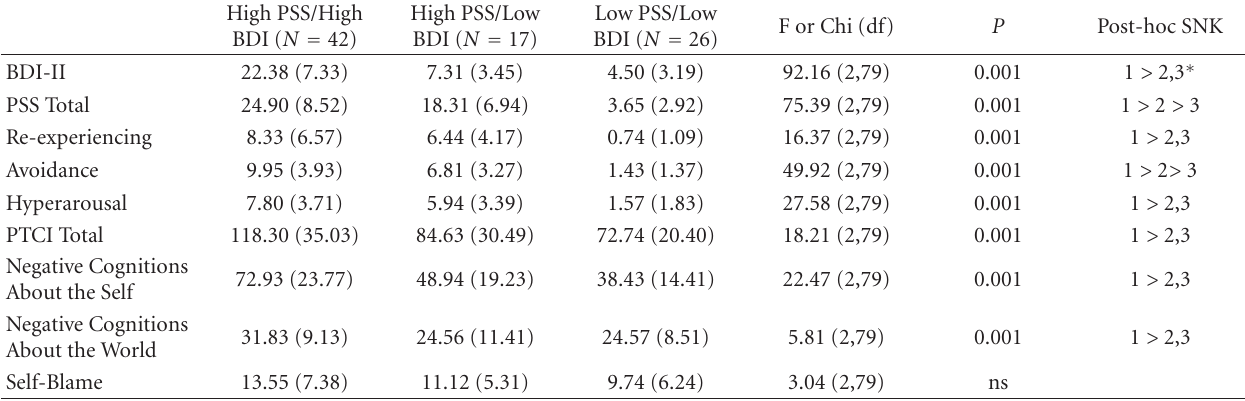
Table 3: Clinical characteristics of the High PSS/High BDI, High PSS/Low BDI, and Low PSS/Low BDI groups. Mean scores (standard deviations) are reported for each